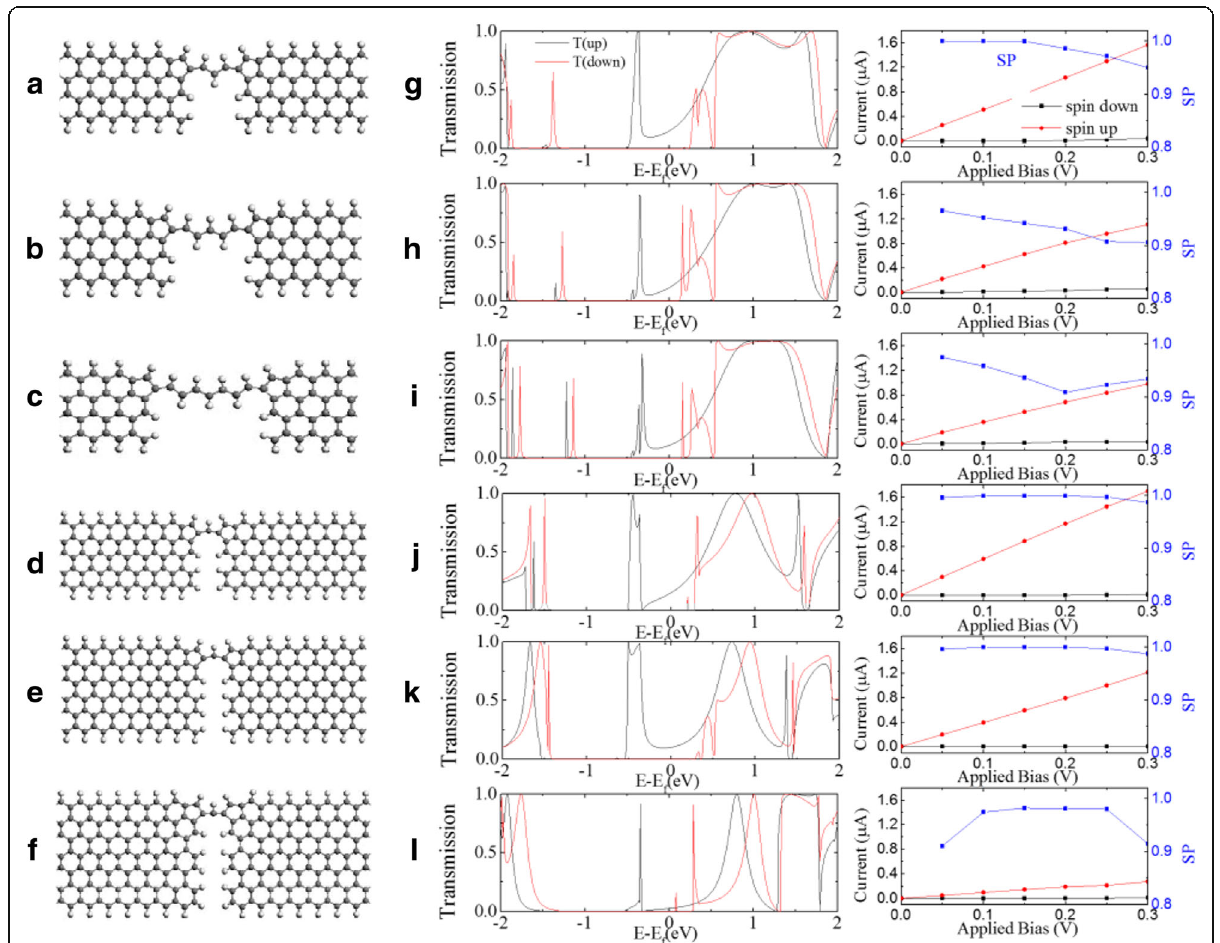
Fig. 6 The spin-dependent transmission, spin-resolved current and spin polarization ( g – l ) corresponding to different tailored ZGNR structures ( a – f ) at magnetic configuration [1,1]. The structure a – c is optimized after symmetrically removing more carbon atoms of 4-ZGNR. The structures d – f are optimized after removing carbon atoms of 5-ZGNR, 6-ZGNR and